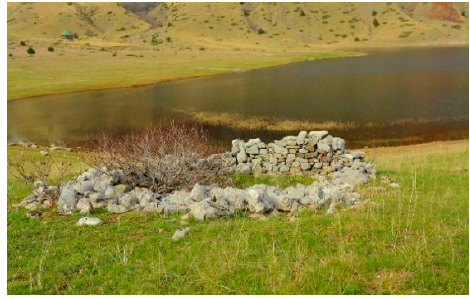
Figure 8. Katun next to the lake—Rikavac, photo: I. Lakovi ć